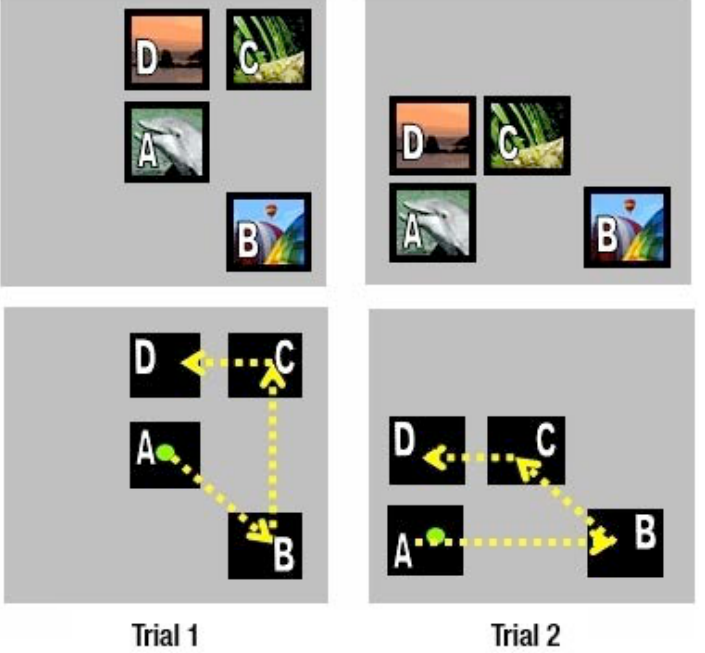
Figure 1. The Simultaneous Chaining paradigm. The task was to touch the items in the prescribed order, regardless of their positions on the screen. An example of a 4-item list is shown in two different, random arrangements, as might appear during any trial in a session. The top row shows the arrangement of ordered pictures, and the bottom row indicates the correct path of